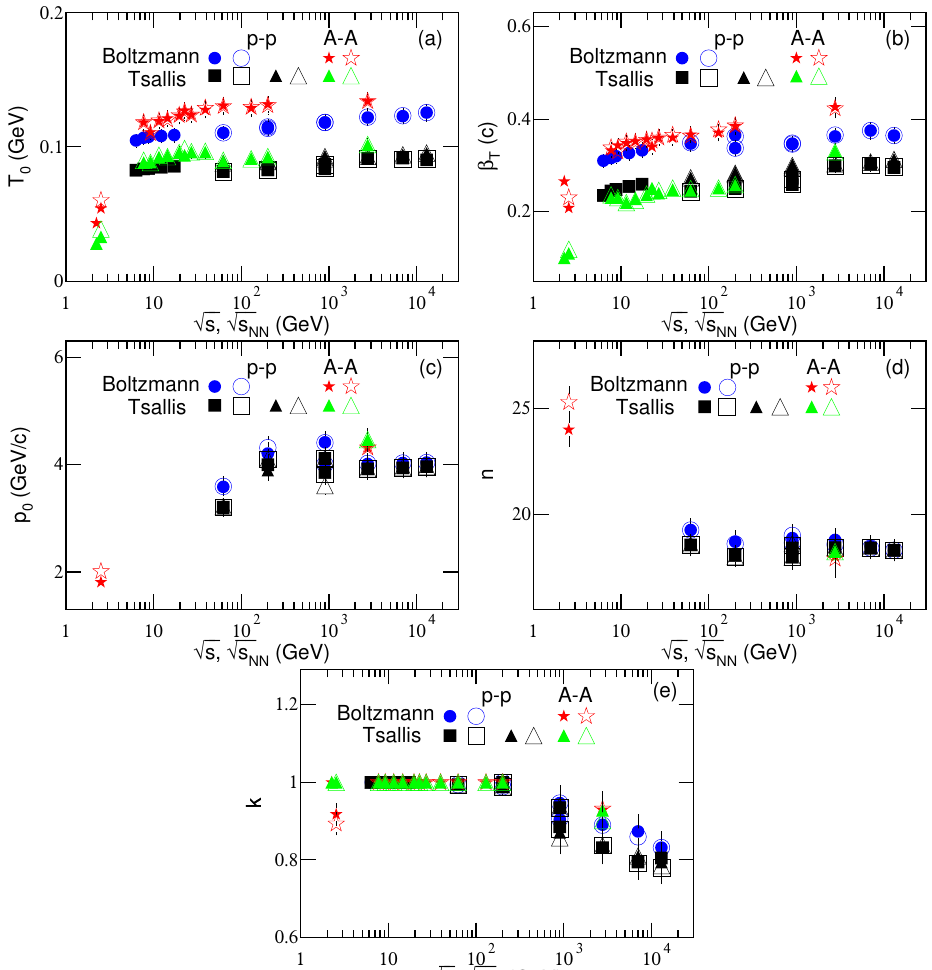
Figure 5. Same as Figure 2, but showing the results obtained from Equation (8) through Equations (1) and (3) with one set of parameter values and from Equation (8) through Equations (2) and (3) with two sets of parameter values, where the excitation functions of T 0 , β T , p 0 , n , and k are presented in panels ( a – e ), respectively. The blue circles represent the parameter values obtained from Equation (8) through Equations (1) and (3). black The squares (triangles) represent the first (second) set of parameter values obtained from Equation (8) through Equations (2) and (3). The related parameter values are listed in Tables 3 and 4. The red asterisks (green triangles) represent the parameter values from AA collisions for comparisons, which are listed in Tables A3 and A4 in the Appendix